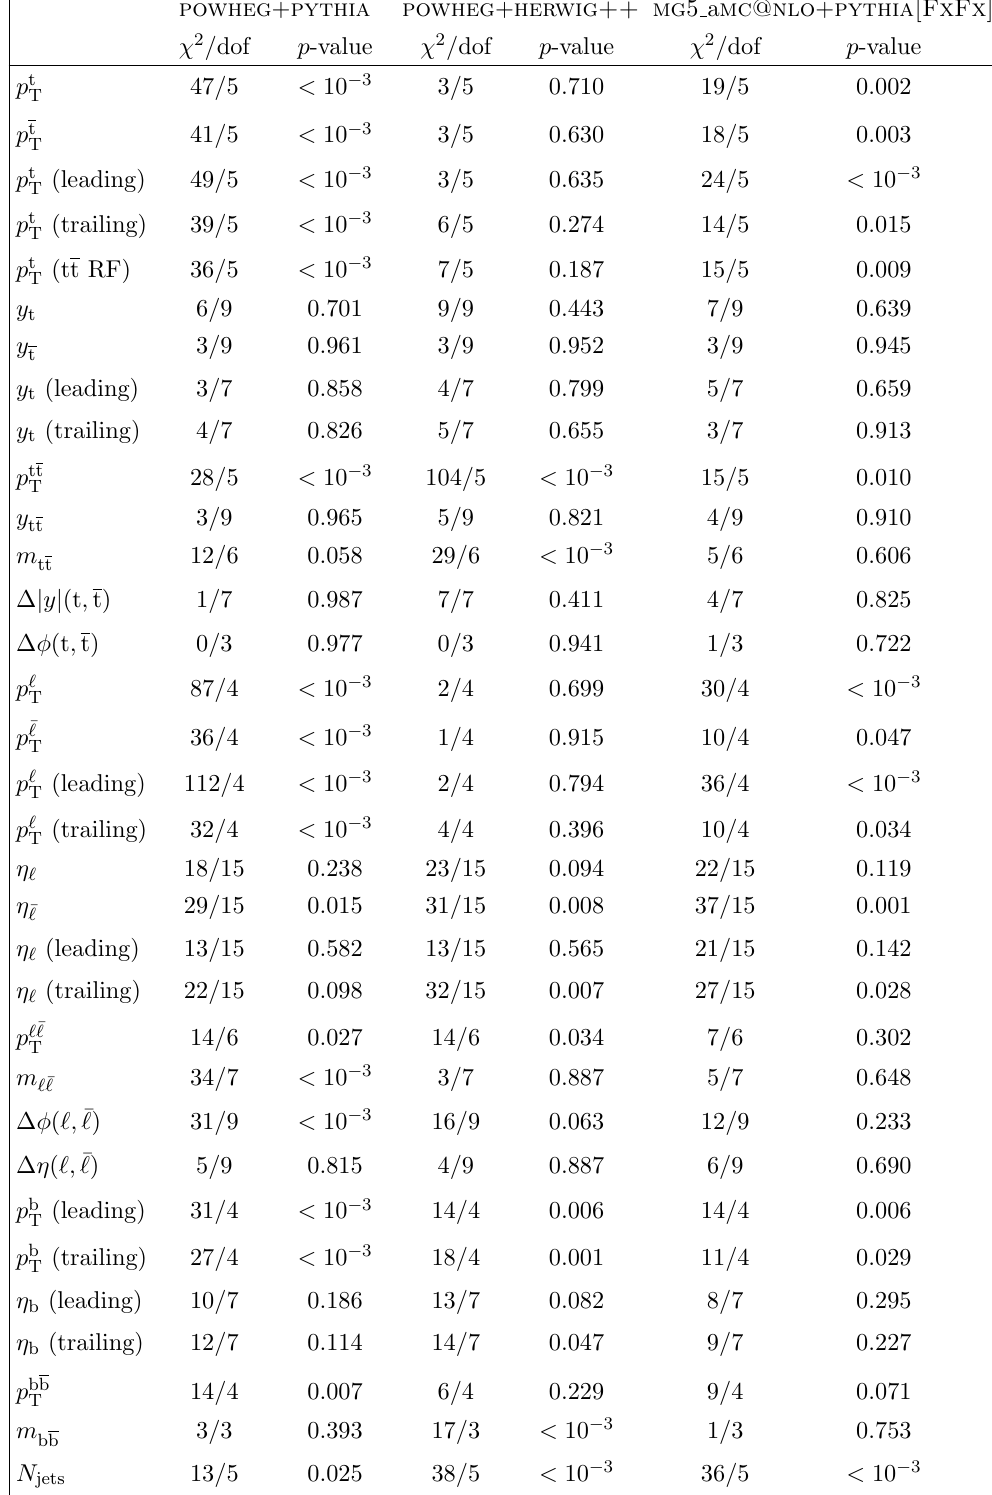
Table 54 . The (cid:31) 2 /dof and p -values quantifying the agreement between the three MC predictions and the measured, particle-level normalised cross sections are shown.